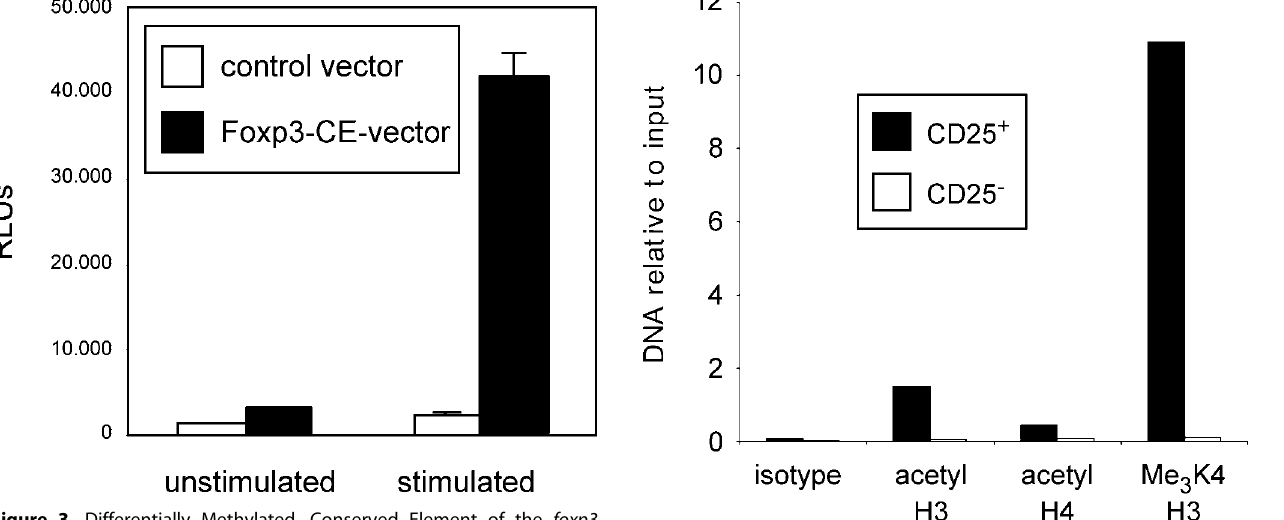
Figure 3. Differentially Methylated, Conserved Element of the foxp3 Locus Possesses Transcriptional Activity RLM-11–1 cells were transfected with control vector (pGL3 promoter) or Foxp3-CE vector containing the conserved element (CE). Cells were stimulated with PMA for 24 h. Control cells were left unstimulated. Results given are relative luciferase light units (RLUs) normalized for Renilla luciferase activity (mean 6 standard deviation; n ¼ 3). Results are representative for two independent